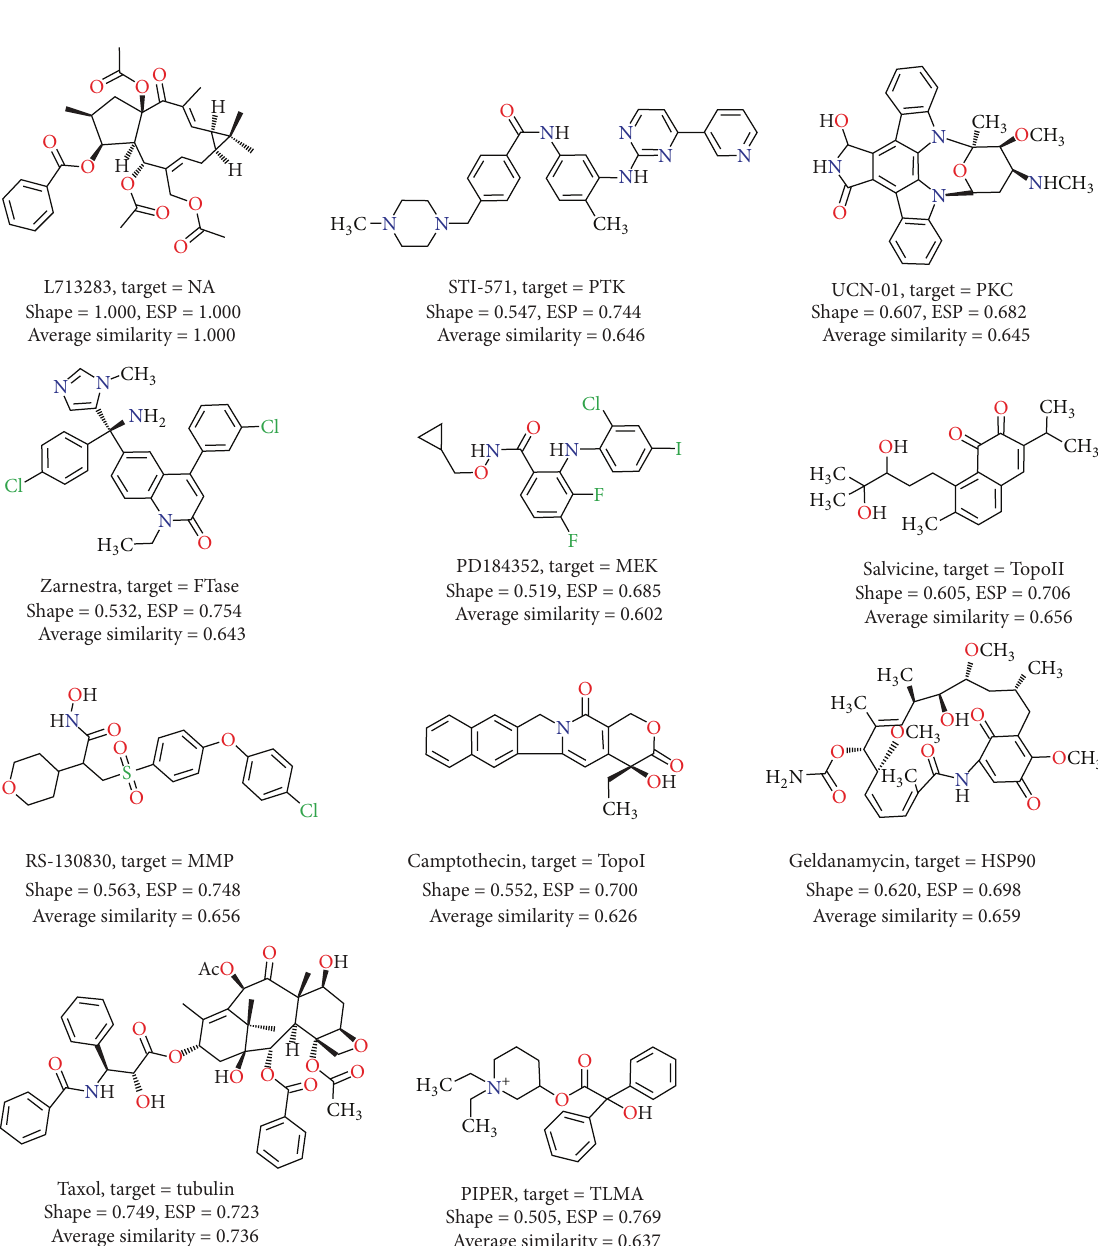
Figure 3: Molecular similarity of L713283 to ten known anticancer